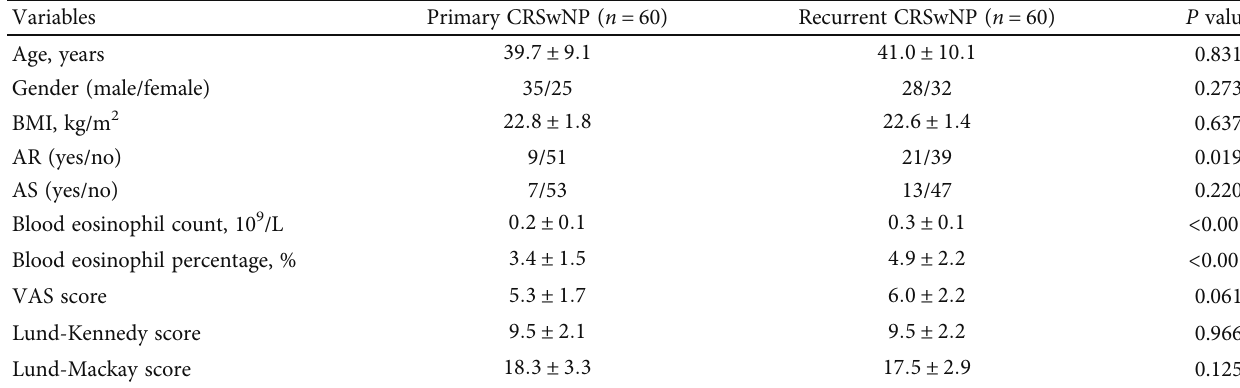
Table 4: The demographic and clinical variables between the two groups.